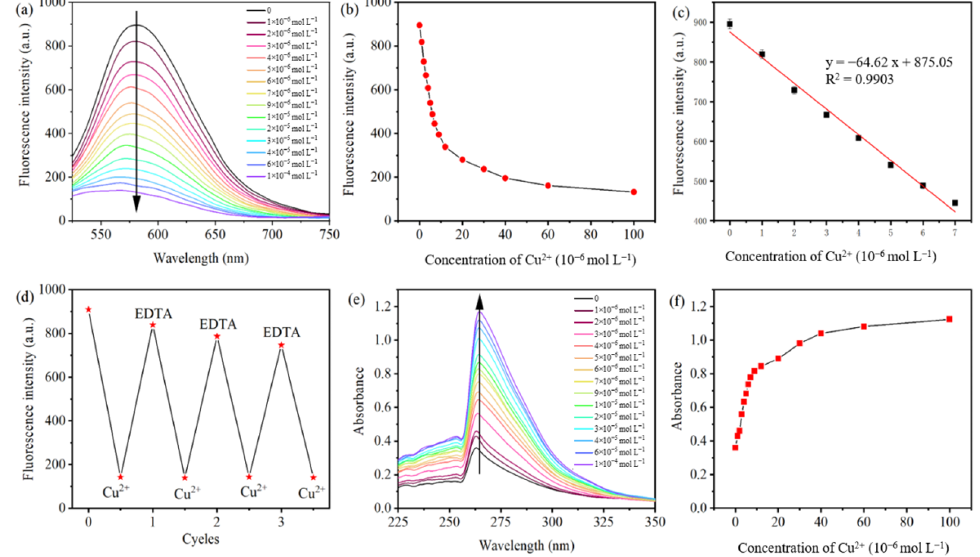
Figure 7. ( a ) Fluorescence spectra and ( b ) maximum emission intensity changed at 579 nm of CMC−GE−AQ solution with different concentrations of Cu 2+ (0~10 −4 mol L −1 ). ( c ) Relationship between fluorescence intensity at 579 nm and different Cu 2+ concentrations (0~7 × 10 −6 mol L −1 ). ( d ) The reversible changes of fluorescence intensity of CMC−GE−AQ to Cu 2+ for 3 cycles. ( e ) UV–Vis absorption spectra and ( f ) maximum absorbance changed at 263 nm of CMC−GE−AQ solution with different concentrations of Cu 2+ (0~10 −4 mol L −1 ). (CMC−GE−AQ: 1.5 × 10 −4 g mL −1 ; Solvents: DMF/H 2 O solution ( v / v = 8/2, pH = 7); Excitation wavelength: 425 nm; Excitation slit: 5 nm). Table 2. Comparison of CMC−GE−AQ with other Cu 2+ probes.